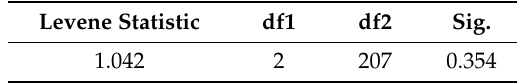
Table 1. Test of homogeneity of variance.